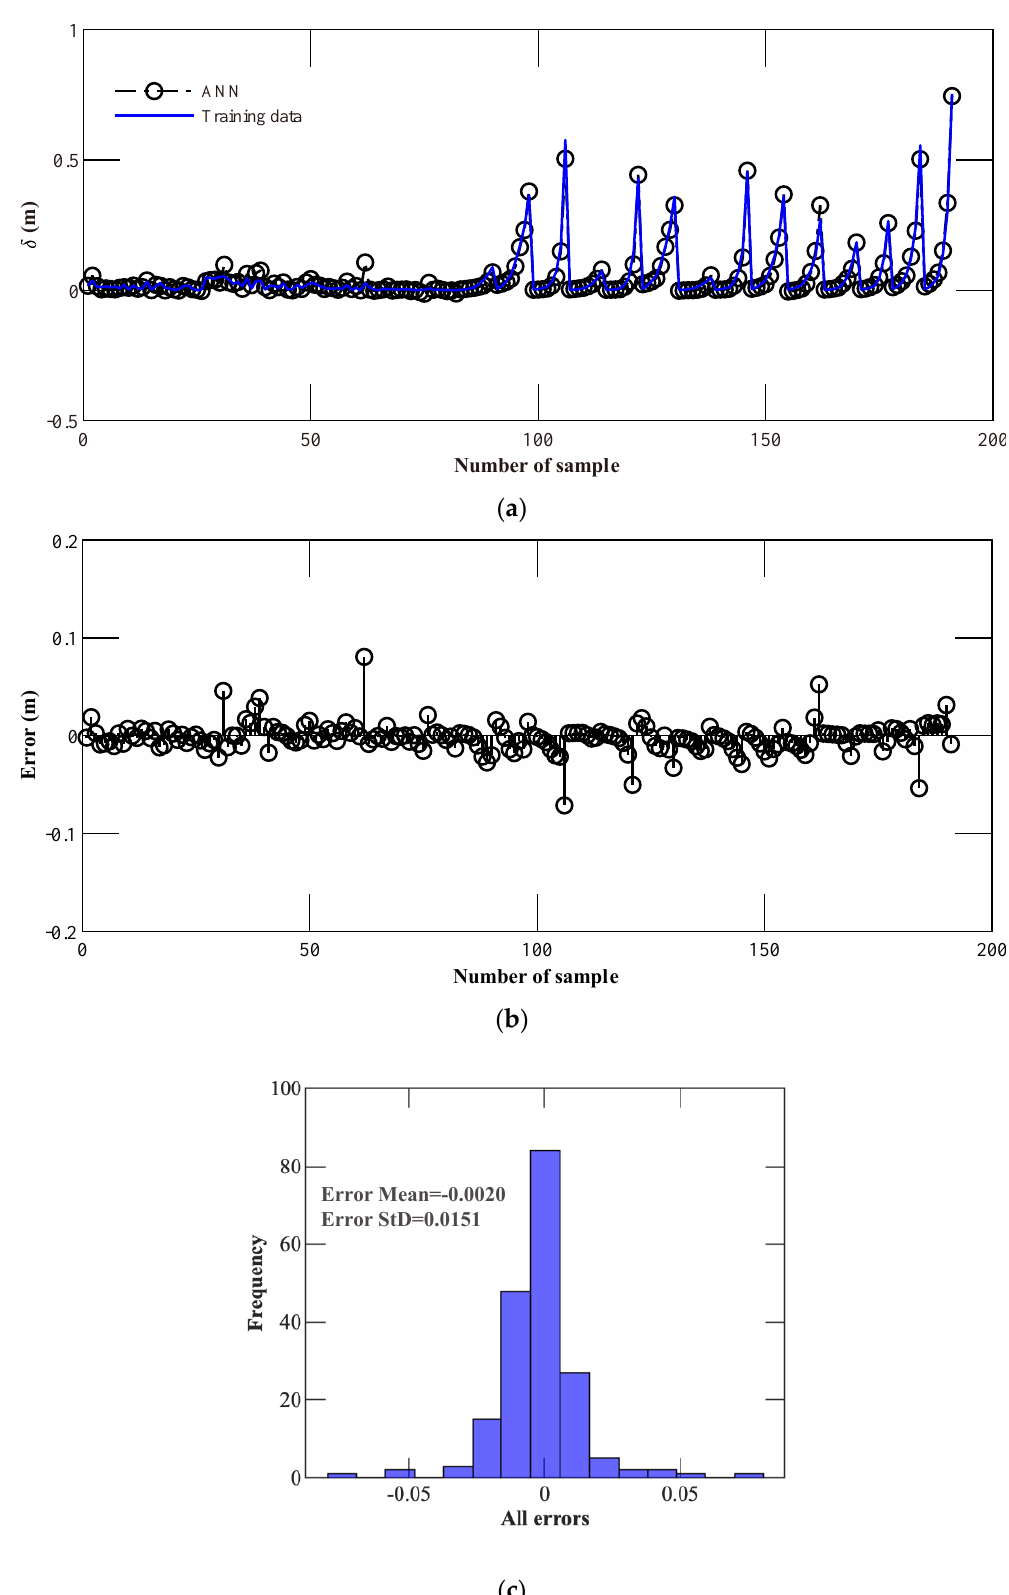
Figure 12. The performance of all data: ( a ) Predicted versus actual data; ( b ) error; ( c ) the histogram of error values.